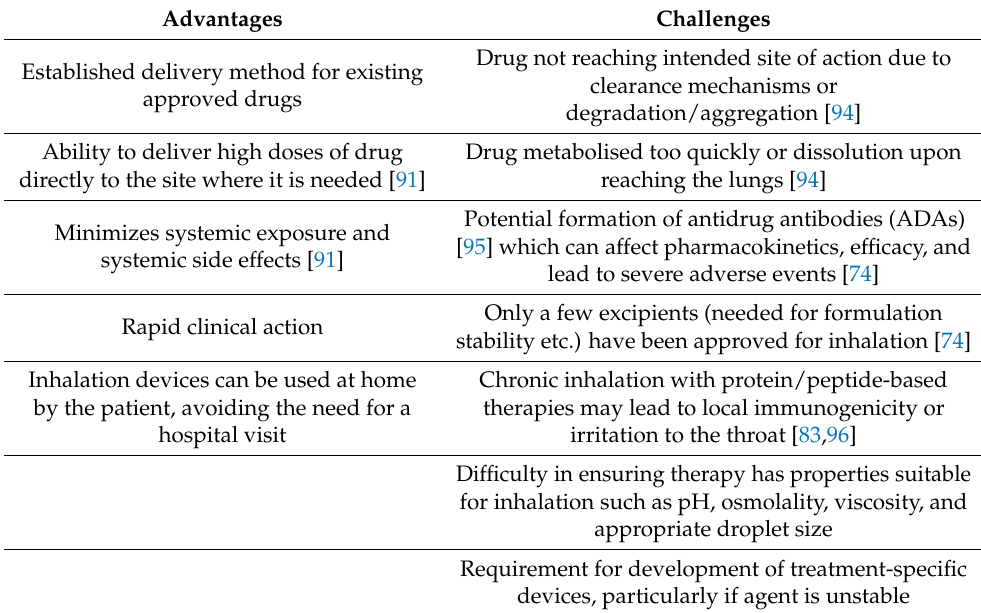
Table 2. Advantages and challenges of inhaled therapies for RTDs.